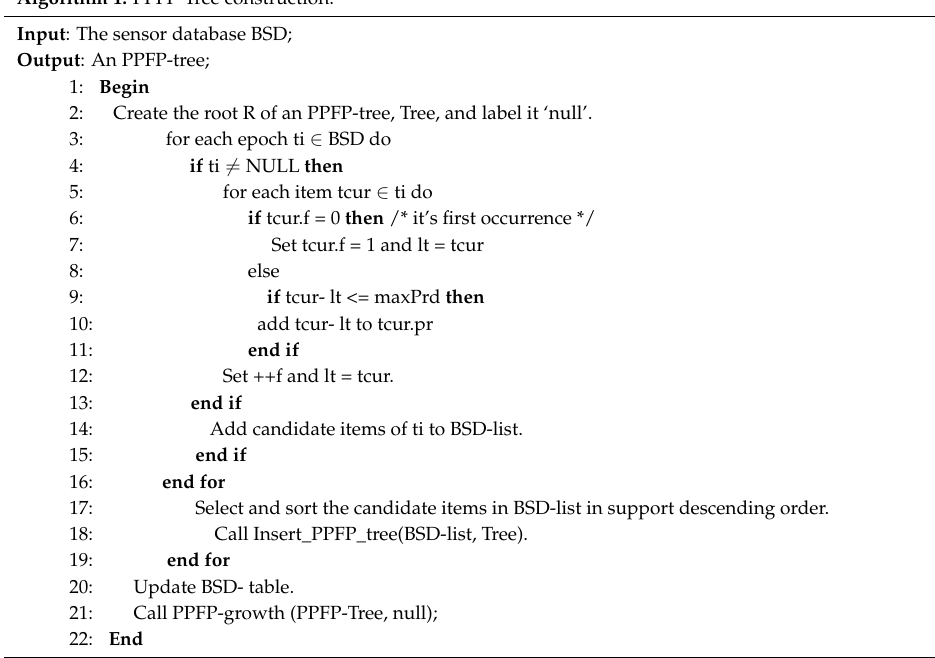
Algorithm 1: PPFP-Tree